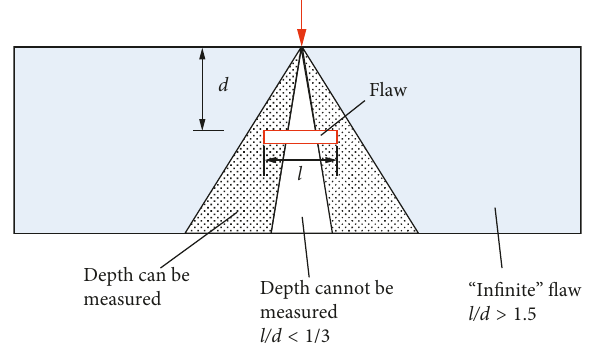
Figure 3: Smallest detectable horizontal crack or void [1] ( l � length of flaw; d � depth of